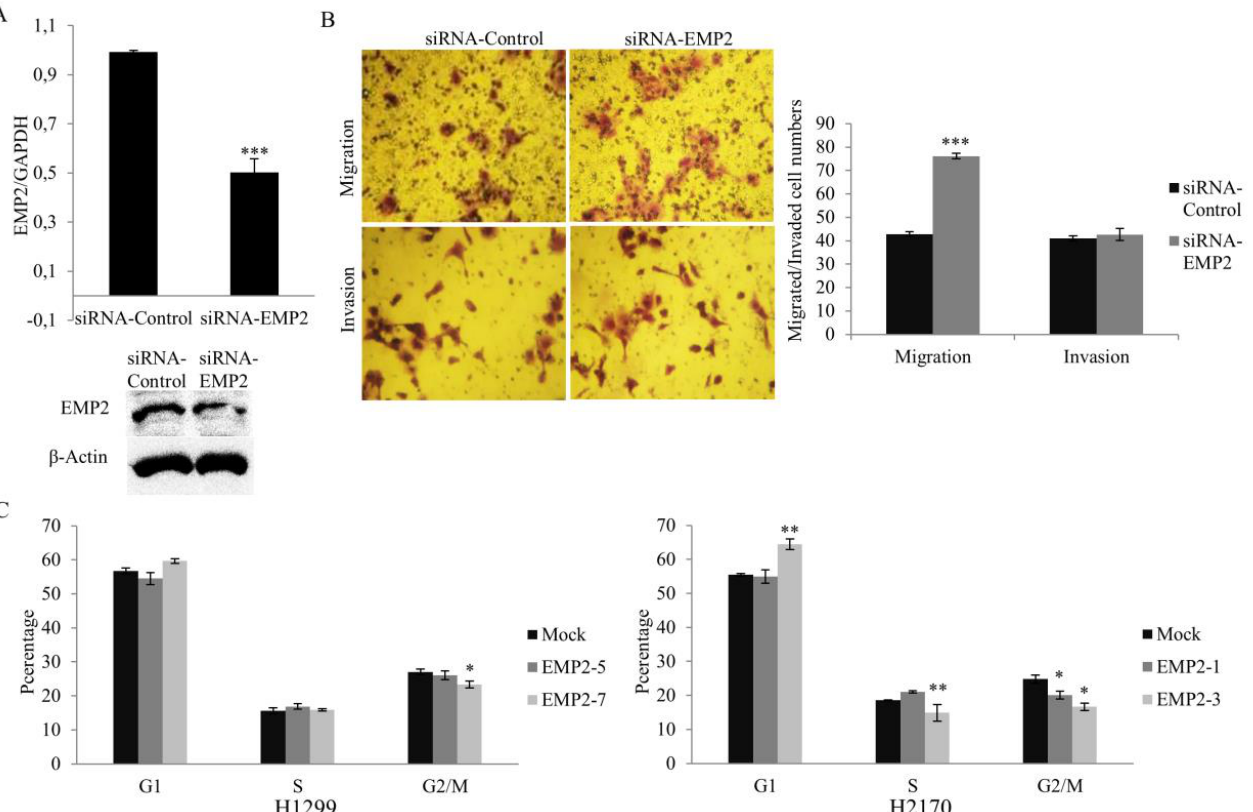
Figure 4. Effect of EMP2 knockdown on cell migration and invasion as well as the impact of EMP2 overexpression on the cell cycle. ( A ) Decreased expression of EMP2 in H1650 cells by siRNA knockdown was confirmed with real-time RT-PCR (top) and Western blotting (bottom). ( B ) Migration assay revealed that knockdown of EMP2 increased migratory ability of H1650 (50 × objective; top), but the invasion assay did not reveal a significantly enhanced ability of tumor cell invasion after EMP2 siRNA knockdown (50 × objective; bottom); quantification of migrated and invaded cell (right). Cells transfected with scrambled siRNA (siRNA Control) were used as control. ( C ) Flow cytometry showed that EMP2 overexpression led to a reduced H1299 cell population in G2/M, alongside an increased H2170 cell population in G1 and decreased cell populations in the S and G2/M phases. * p < 0.05, ** p < 0.01, *** p < 0.001 when analyzed using Student’s t -test.